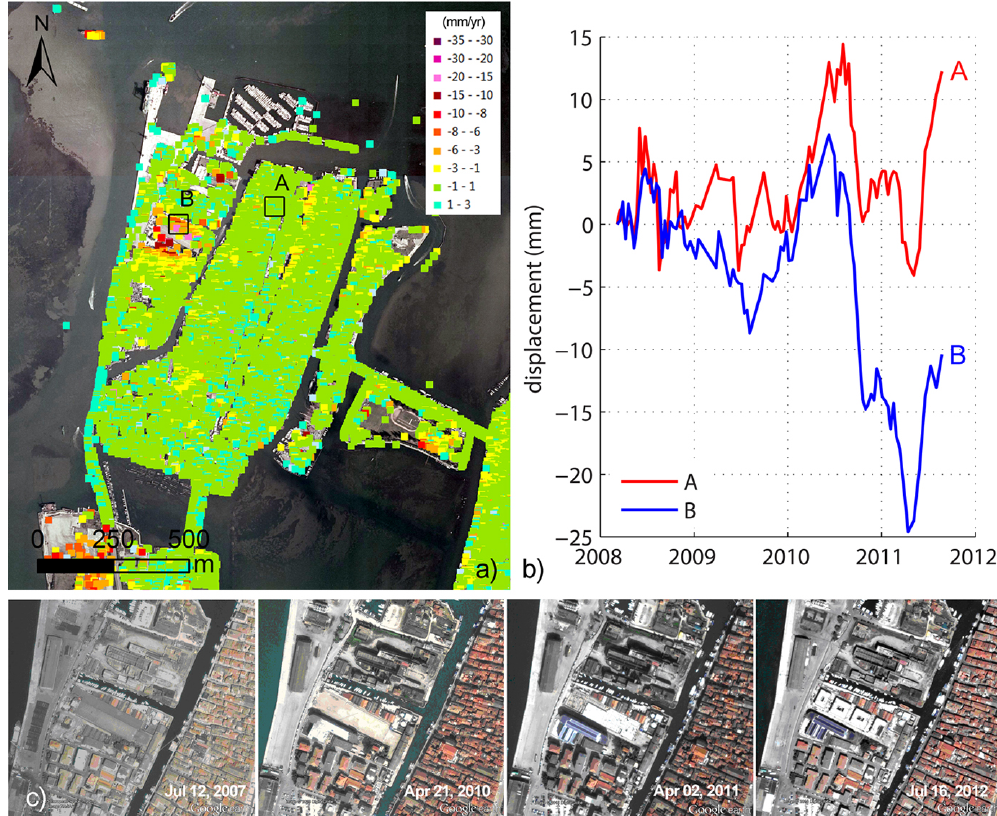
Figure 5. (a) Mean displacement rates between March 2008 and August 2011 from TerraSAR-X interferometry at Chioggia. The image background is an aerophotograph acquired in 2007. Negative values indicate settlement, positive mean uplift. (b) Displacement history in the satellite line-of-sight direction for two scatterers (A, B). (c) Satellite Google Earth images showing the building construction carried out at location B from 2010, cause of the large consolidation highlighted by PSI measurements in the zone from mid-2010 (Google Earth, data source: European Space Imaging, Image NASA; Digital Globe, Image). See location 3a in Fig.